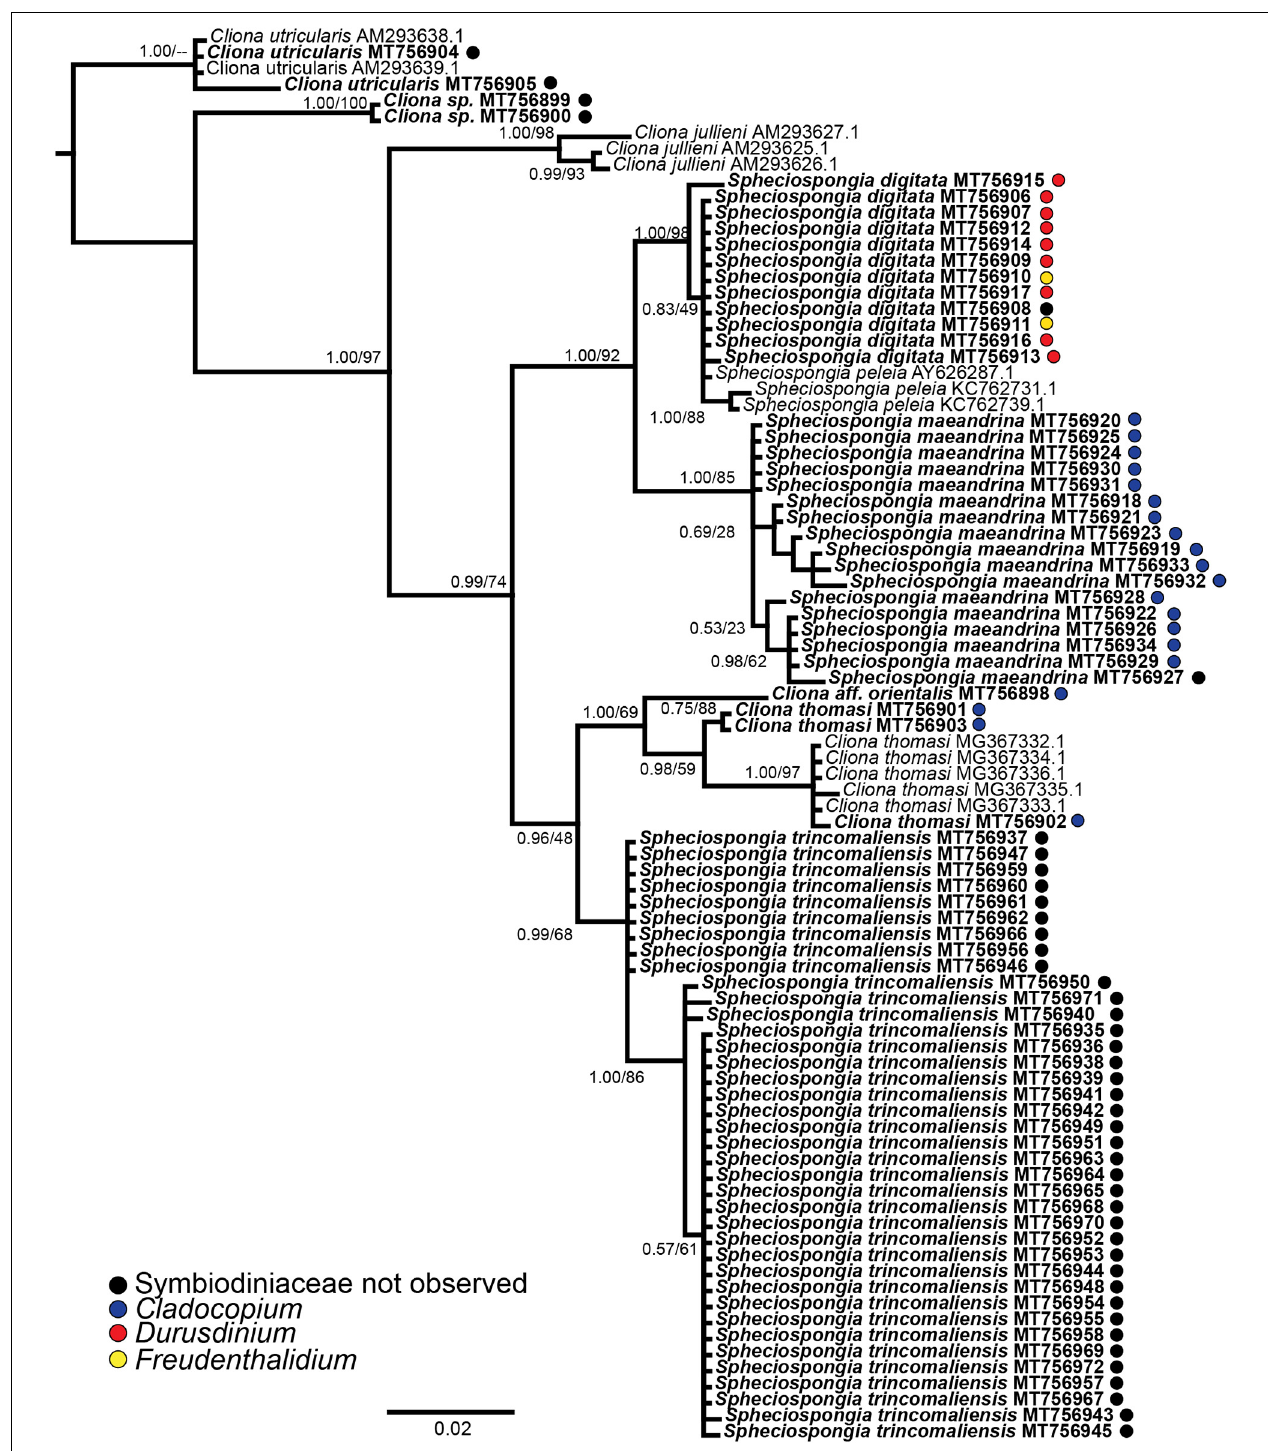
FIGURE 1 | Phylogenetic tree resulting from the Bayesian analysis of 28S rDNA from all available Indo-Pacific Cliona and Spheciospongia species. Node support values indicate posterior probability values and PhyML bootstrap values, respectively. Sequences derived in this study are displayed in bold and if the sample contained Symbiodiniaceae, the identity is given as a a colored dot behind the sequence.